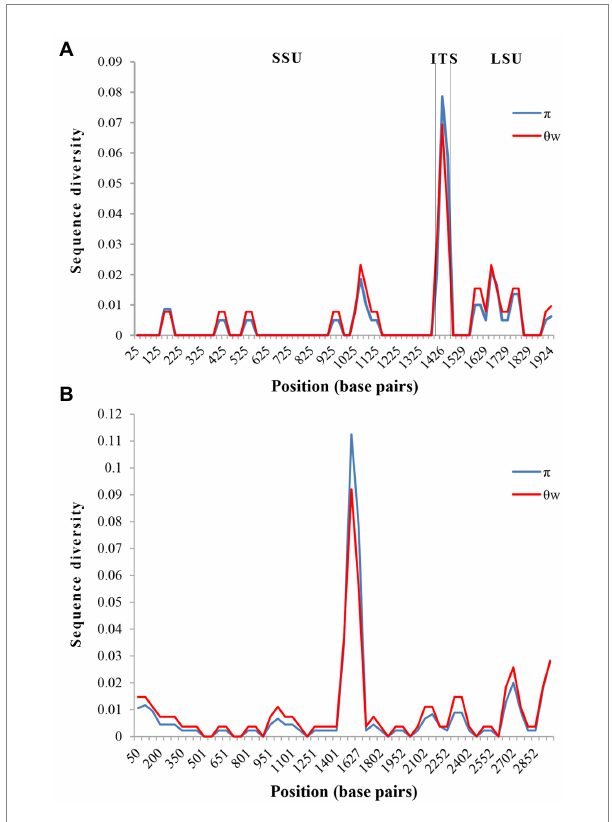
FIGURE 6 Sliding window analysis of nucleotide diversity in the rDNA and Rpb1 of Pseudokabatana alburnus. Nucleotide diversity was calculated as the average heterozygosity per site ( π ) and the average number of nucleotide differences per site ( θ w ). (A) Sliding window analysis of nucleotide diversity in the rDNA of P. alburnus. A sliding window of 50 base pairs was used, with an increment of 25 base pairs. (B) Sliding window analysis of nucleotide diversity in the Rpb1 of P. alburnus. A sliding window of 100 base pairs was used, with an increment of 50 base